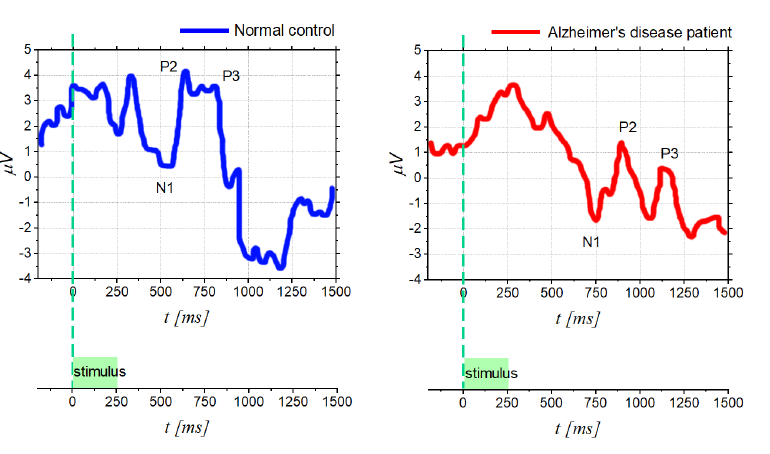
Figure 6. OERPfor a normal control subject and for a patient with Alzheimer’s disease (age 79), recorded at Pz position